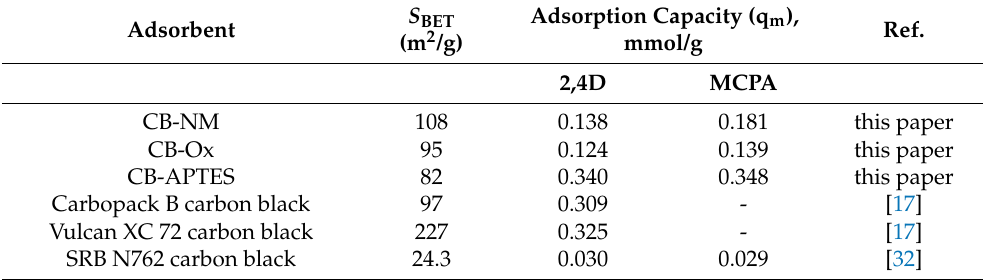
Table 6. Adsorption capacities of 2,4-D and MCPA on various carbonaceous